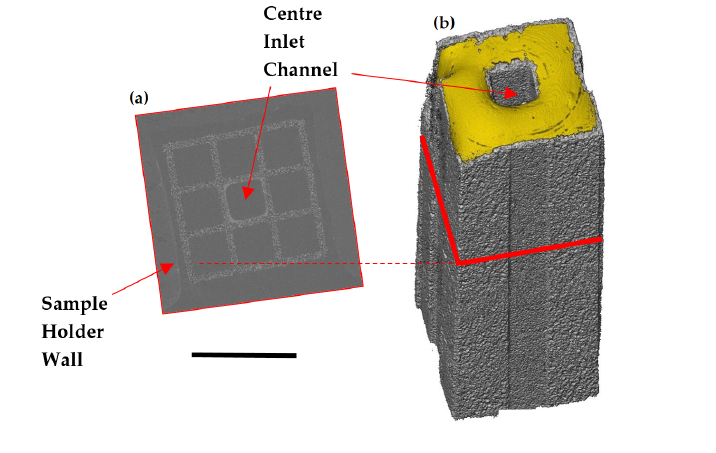
Figure 3. Micro-CT slice ( a ) and a micro-CT volume ( b ) showing a typical wall flow filter sample. Samples cut from the monoliths were 2–3 cm long, with 3 × 3 channels, as shown in the slice image. Aerosol entered the filter through the centre channel, indicated in the figure, and was prevented from entering the exterior channels which were plugged with epoxy resin, shown here in gold. The centre channel is blocked in the same way at the downstream end. Scale bar = 4